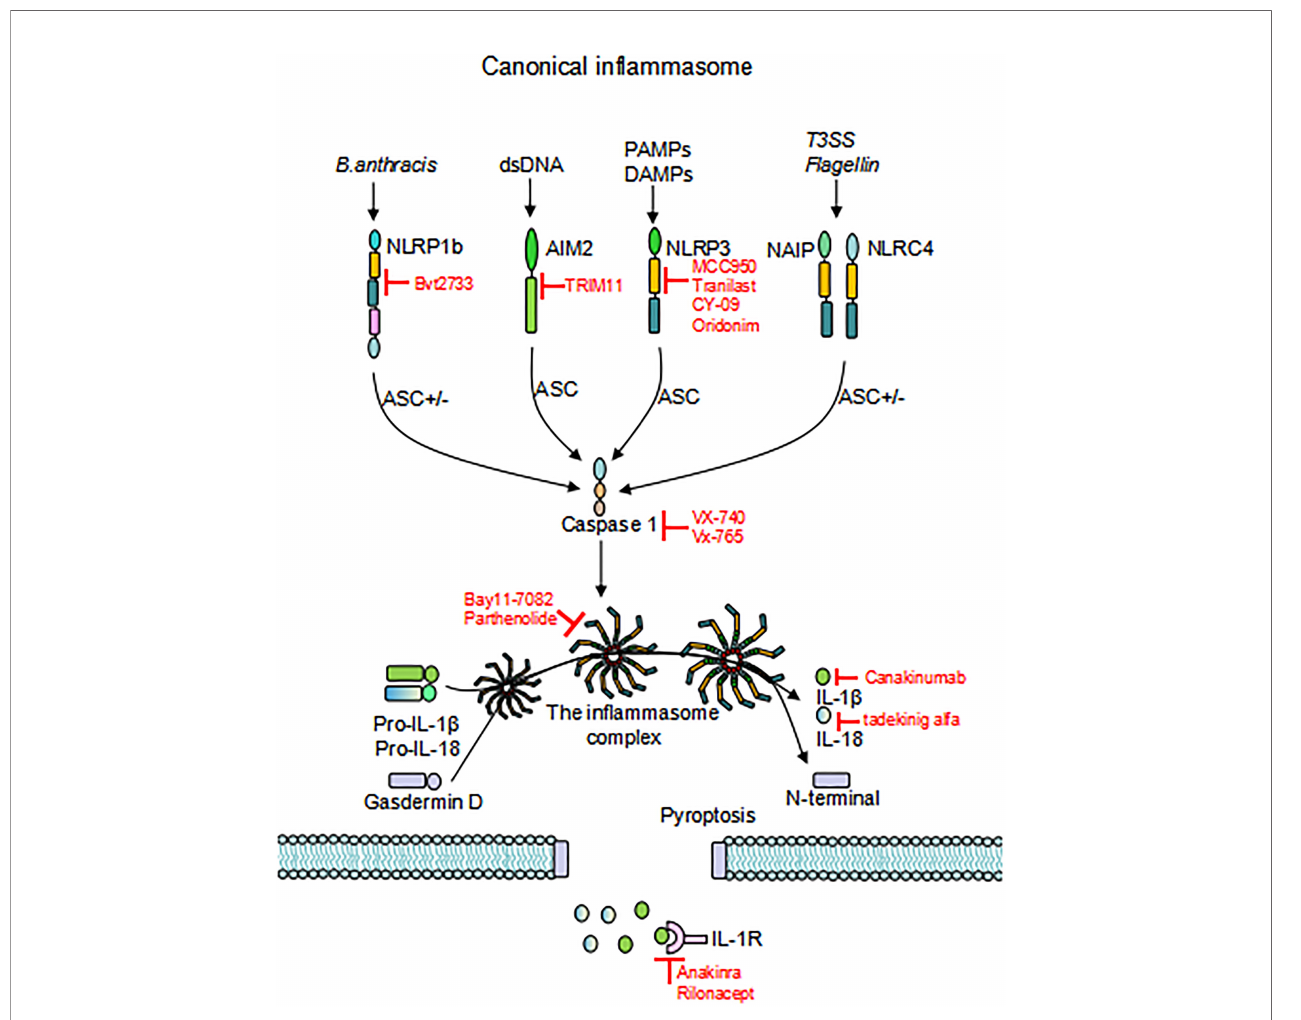
FIGURE 2 | Activation of in fl ammasomes. Different in fl ammasome sensors sense different ligands, canonical in fl ammasome activation occurs through the response to PAMP/DAMP/HAMP. Upon initiation and activation, the in fl ammasome complex assembles, inducing caspase-1 self-cleavage and activation, and cleaves GSDMD to release the N-terminal domain and induce pyroptosis. Activated caspase-1 promotes cleavage of pro-IL-1 b and pro-IL-18 to activate IL-1 b and IL-18, which are released through the GSDMD pore. Inhibitors that target in fl ammasomes are also depicted in the Figure. “ ASC+/- ” means this activation pathway is independent of ASC; PAMP, pathogen-associated molecular patterns; DAMP, damage-associated molecular patterns; HAMP, homeostasis-altering molecular processes; GSDMD, gasdermin